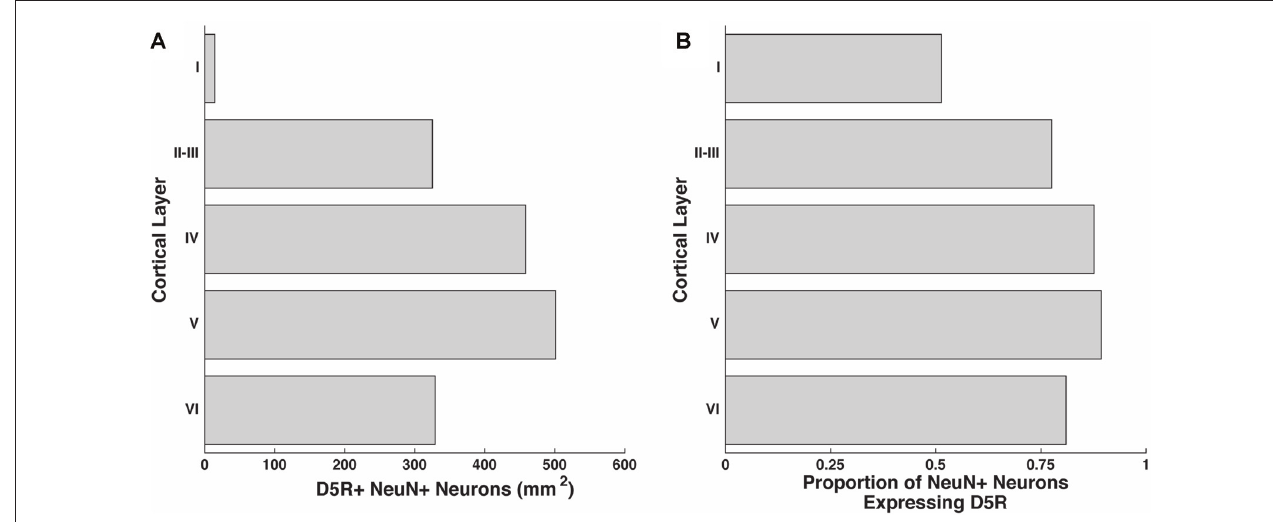
FIGURE 1 | Distribution of D5Rs across cortical layers. (A) Number of NeuN+ neurons that co-express D5R for cortical layers I, II–III, IV, V and VI per mm 2 . (B) Proportion of NeuN+ neurons that express D5Rs for cortical layers I, II–III, IV, V and VI.